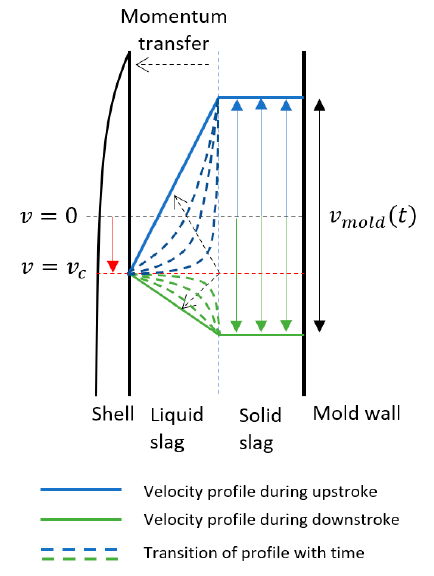
Figure 4. Transition of velocity profile in liquid slag film during mold oscillation cycle.